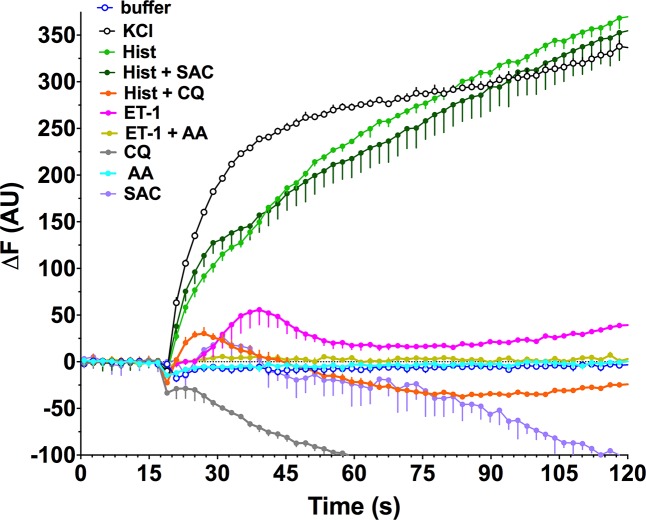
Heterogeneity of HASM membrane potential responses evoked by procontractile agonists co-treated with TAS2R agonists.Cultured HASM cells were studied using a fluorescence-based membrane potential dye. The indicated agents were added singly, or in combination, at the 16 sec time point. The final concentrations were: Hist 3 μM, CQ 50 μM, SAC 50 μM, ET-1 1 μM, AA 50 μM. Results are mean ± SE of triplicate determinations from a single representative experiment of 2–5 performed.